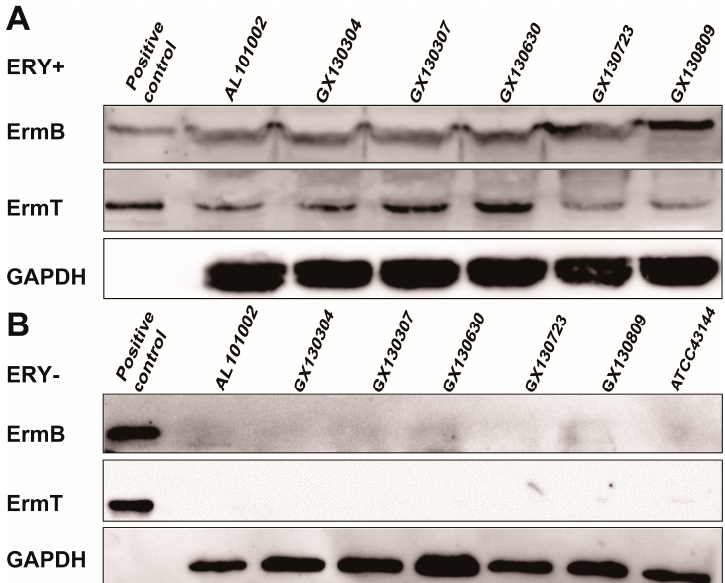
Figure 2. Erythromycin-inducible expression of ermB and ermT : ( A ) ErmB and ErmT protein expression in six isolates with erythromycin; and ( B ) dormancy of ermB and ermT genes in six isolates without erythromycin. Positive controls are purified recombinant ErmB and ErmT proteins tagged with a His6 tail. ErmB and ErmT bands were blotted with mouse serum against above recombinant ErmB or ErmT proteins. GAPDH was used for loading controls and was visualized by monoclonal human GAPDH antibody. ATCC 43144 is a negative control as it lacks ermB and ermT genes.